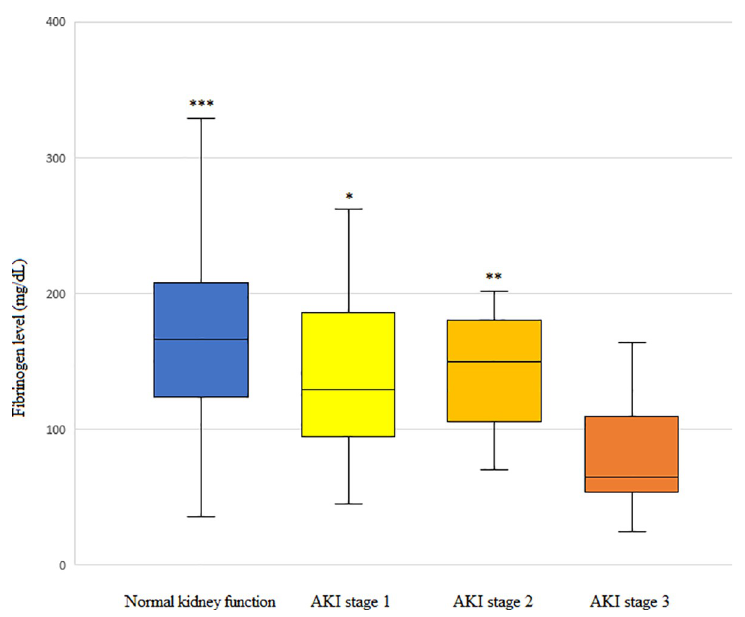
Fig 2. The preoperative fibrinogen level according to the severity of acute kidney injury (AKI). The box plots show the median (line in the middle of the box), interquartile range (box), and 5 th and 95 th percentiles (whiskers). � p = 0.013 vs. AKI stage 3, �� p = 0.006 vs. AKI stage 3, ��� p = 0.001 vs. AKI stage 3.